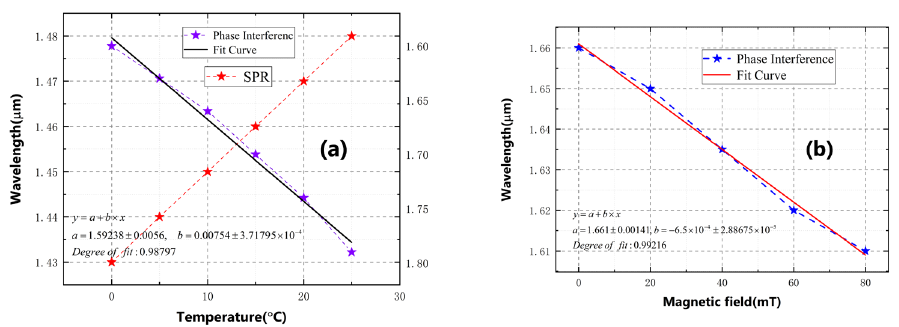
Figure 9. The central wavelength of the formants in Figures 7 and 8 as a function of temperature ( a ) and magnetic field ( b ).